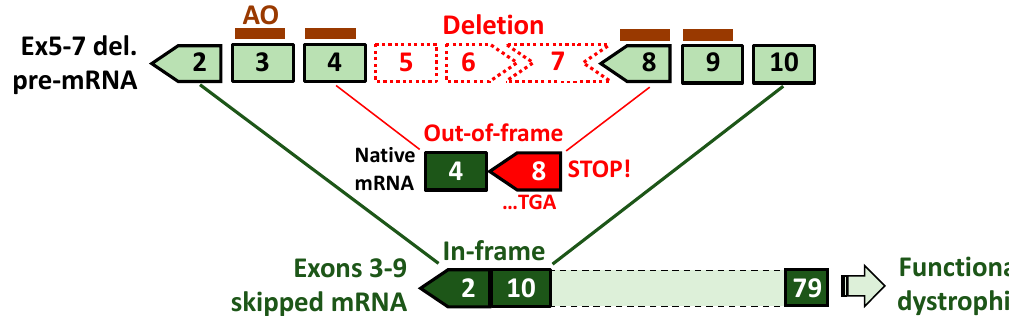
Figure 6. Schematic of exons 3–9 skipping using cocktail antisense oligonucleotides (AOs) for DMD exons 5–7 deletion. Individual AOs are designed to skip each exon within the region of exons 3–9. Native out-of-frame mRNAs do not allow for the production of dystrophin due to a generated premature stop codon in exon 8. Skipping the entire exons 3–9 region by cocktail AOs leads to the expression of truncated but partially functional dystrophin.